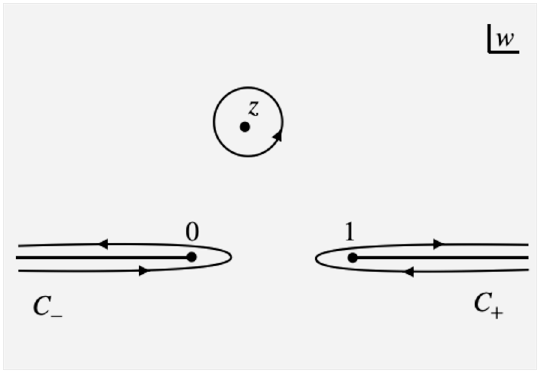
Figure 1 . An illustration of the contours C ±